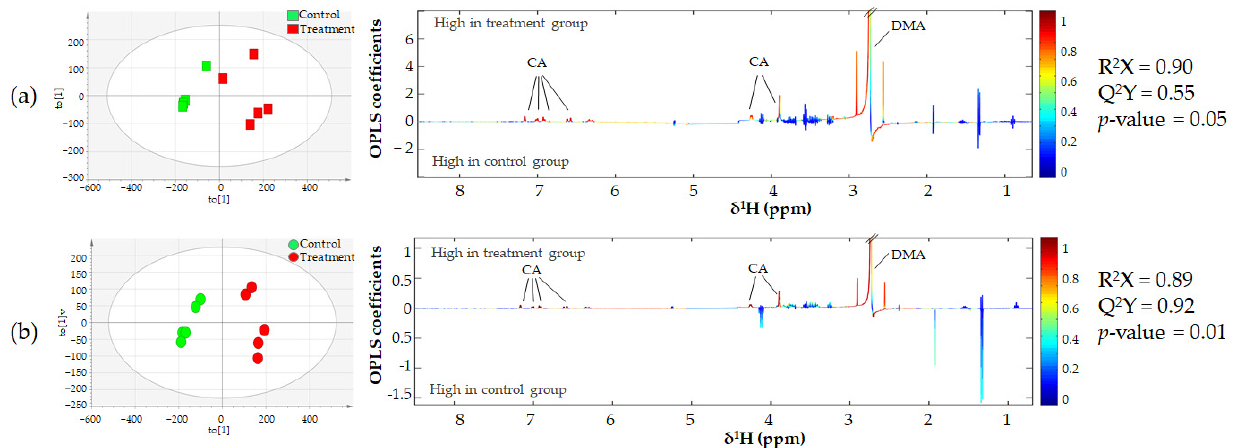
Figure 7. OPLS-DA scores and loading plots displaying significant extracellular metabolites after treatment with or without